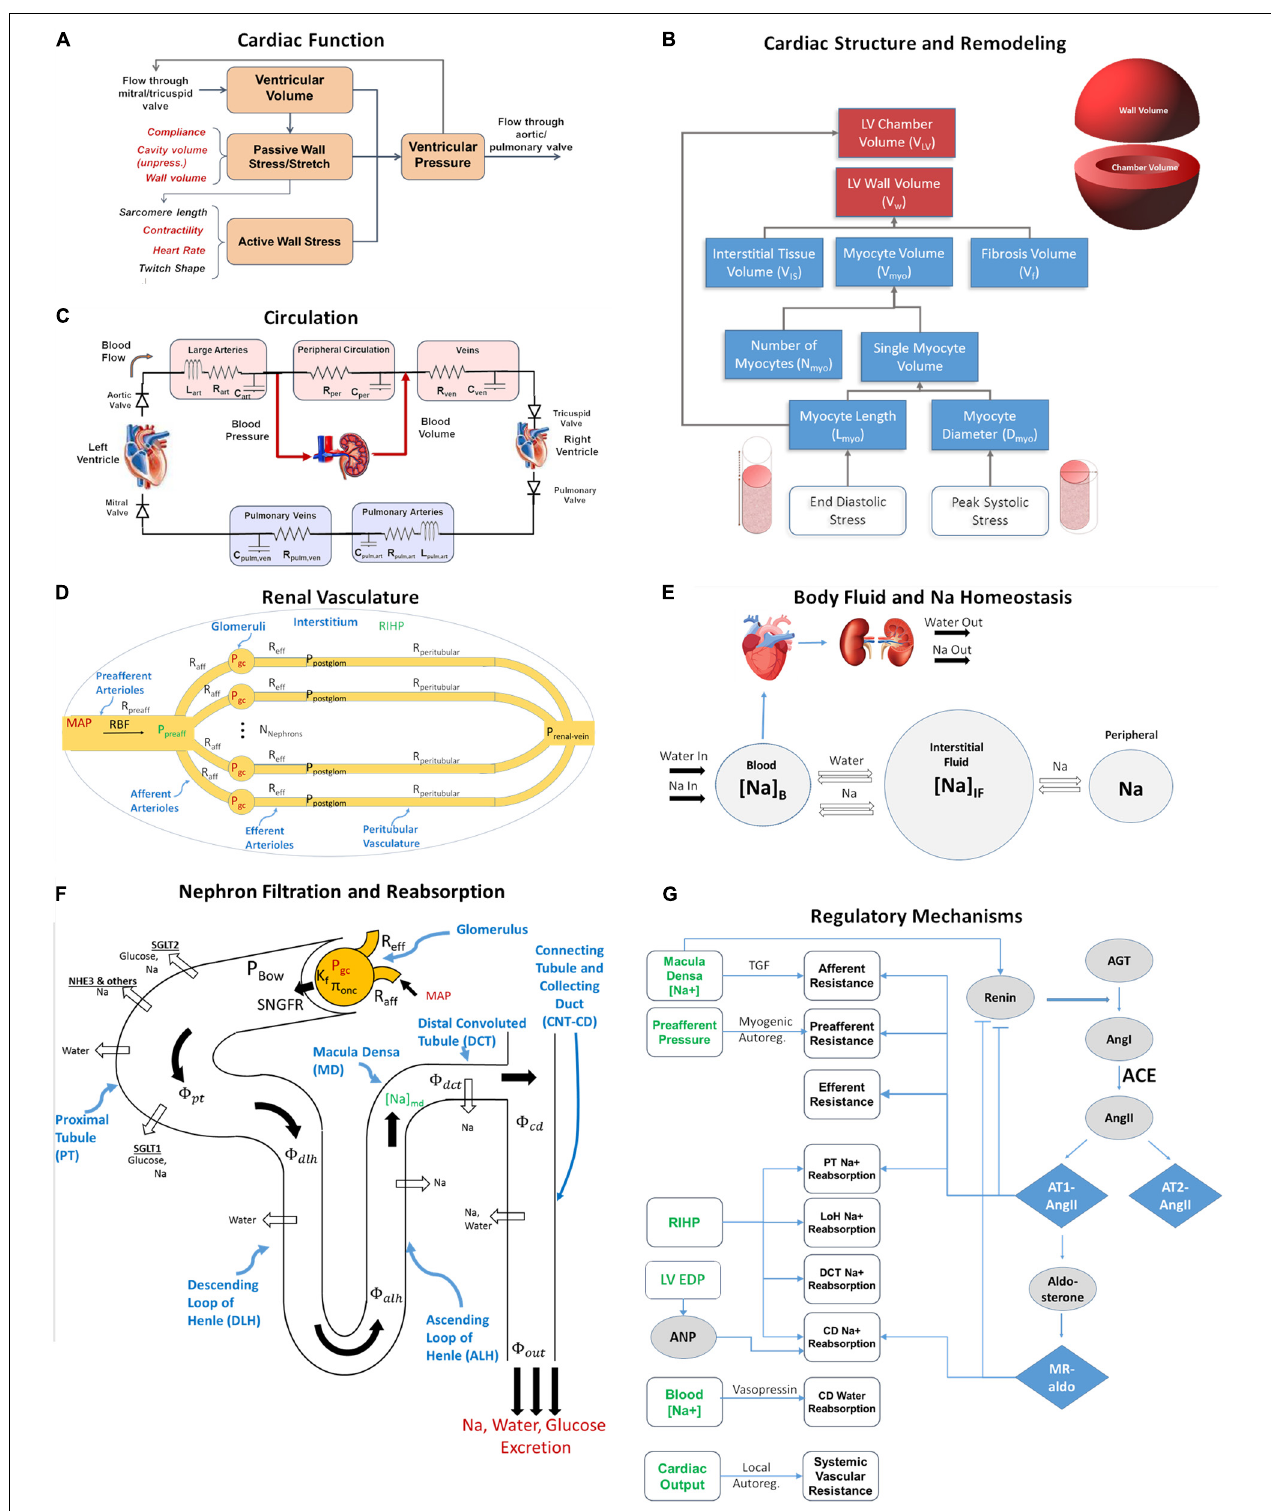
FIGURE 1 | The integrated cardiorenal model links cardiac mechanics (A) and ventricle remodeling (B) , a lumped parameter description of cardiovascular circulation (C) , whole body Na+ and fluid homeostasis (E) , renal hemodynamics (D) , renal filtration and reabsorption (F) , and neurohumoral and intrinsic feedbacks including the renin-angiotensin-aldosterone system (RAAS) (G) . Adapted from Yu et al. (2020).